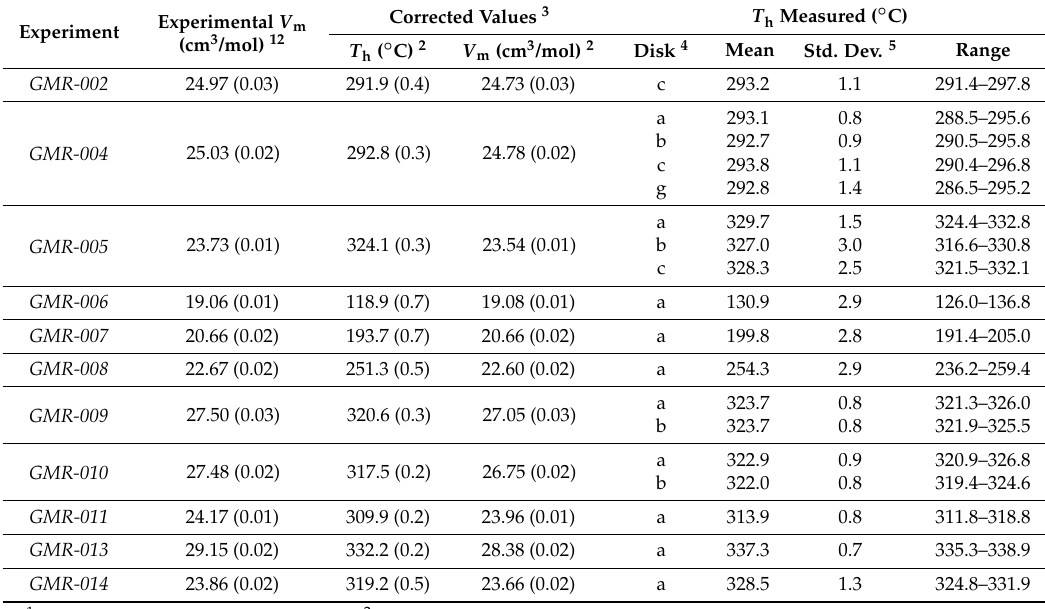
Table 2. Summary of calculated molar volumes ( V m ) and microthermometric data on fluid